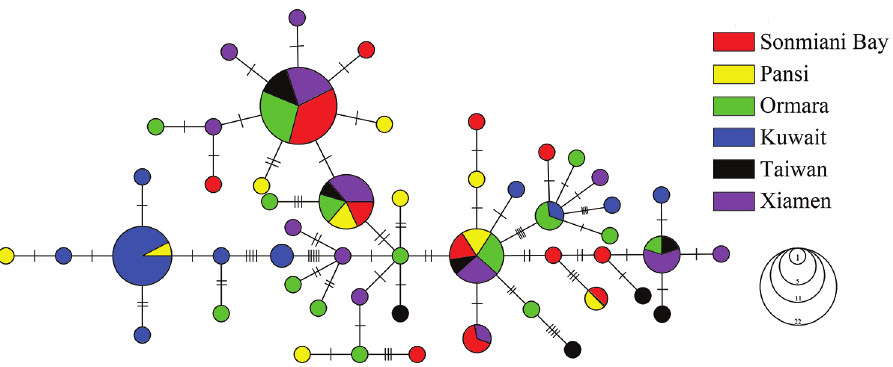
Figure 3. Unrooted minimum spanning tree depicting the genetic relationship among the CR haplo- types of P. argenteus . Circle sizes are proportional to the haplotype frequency. Perpendicular tick marks on the lines joining the haplotypes represent the number of nucleotide substitutions.